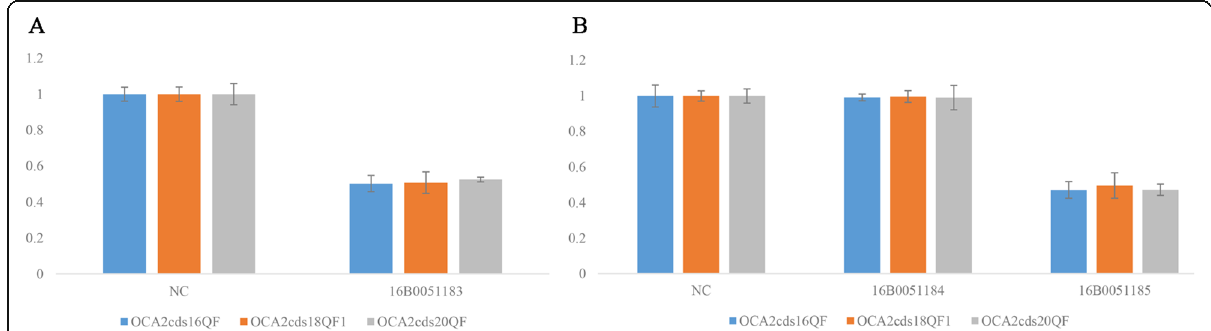
Fig. 4 Confirmation of exons 17 – 21 deletion using qPCR. a The qPCR results of the patient. NC represents the control sample, 16B0051183 represents the patient. b The qPCR results of the parents. 16B0051184 represents the father of the patient, 16B0051185 represents the mother of the